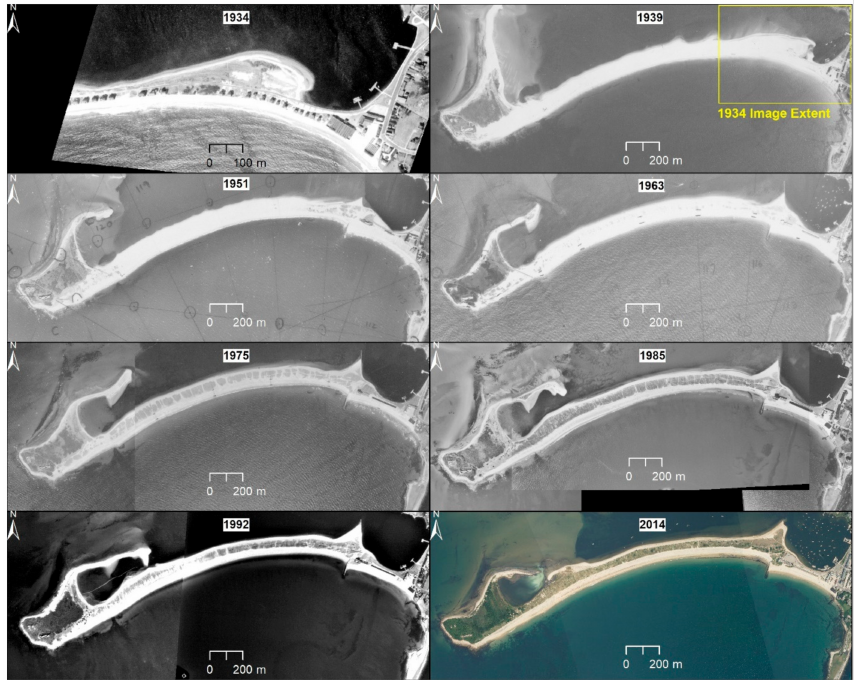
Figure 9. Napatree barrier 1934 through 2014. Only the eastern portion of the barrier was imaged in 1934. Note the houses and vegetation visible in 1934. Images shown from 1939, 1951 and 1963 all show evidence of recent washover fan deposition. Images from 1975 to 2014 show vegetation reestablished along the barrier. The 1992 images show some overwash on the western half of the barrier, but not full removal of the dunes. See the supplemental materials for all aerial images used in this